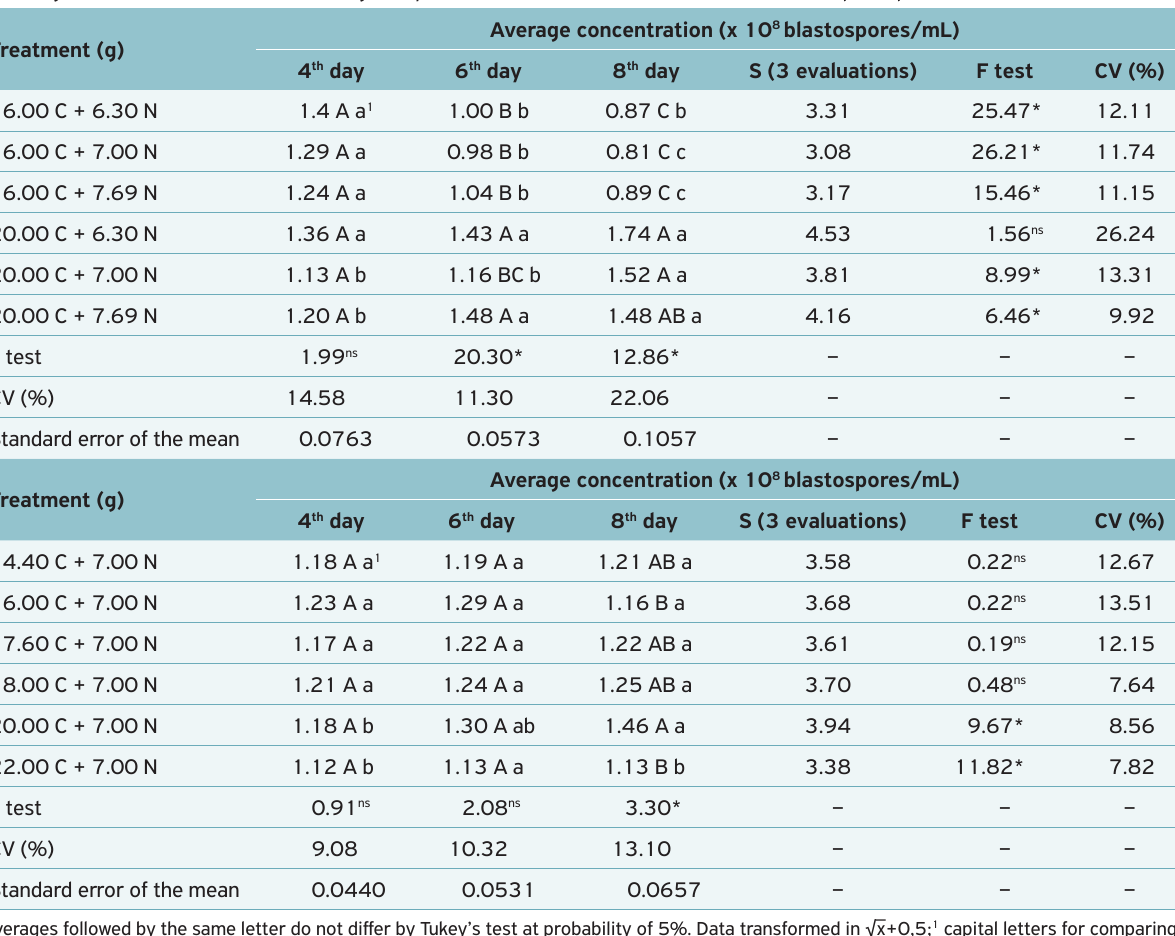
Table 3. Average concentration of Beauveria bassiana (IBCB 66), obtained from liquid culture medium with different concentrations of nitrogen and carbon at four, six and eight days after inoculation (at 26 ± 1°C and 12-hour photophase). Treatment (g)